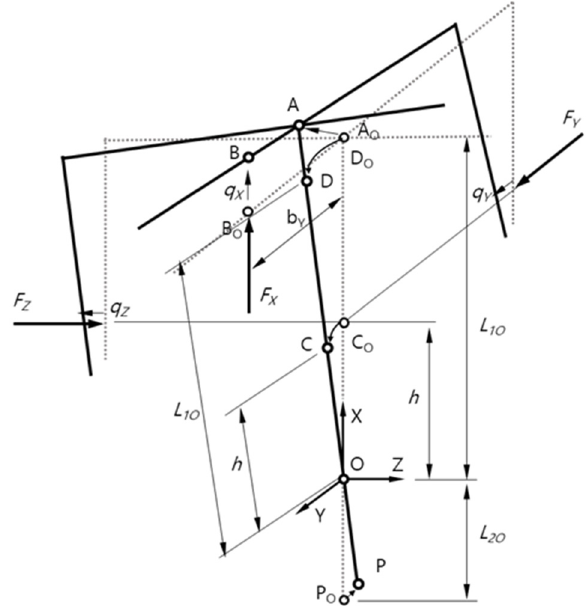
Figure 3. The skeleton of the parallel manipulator.